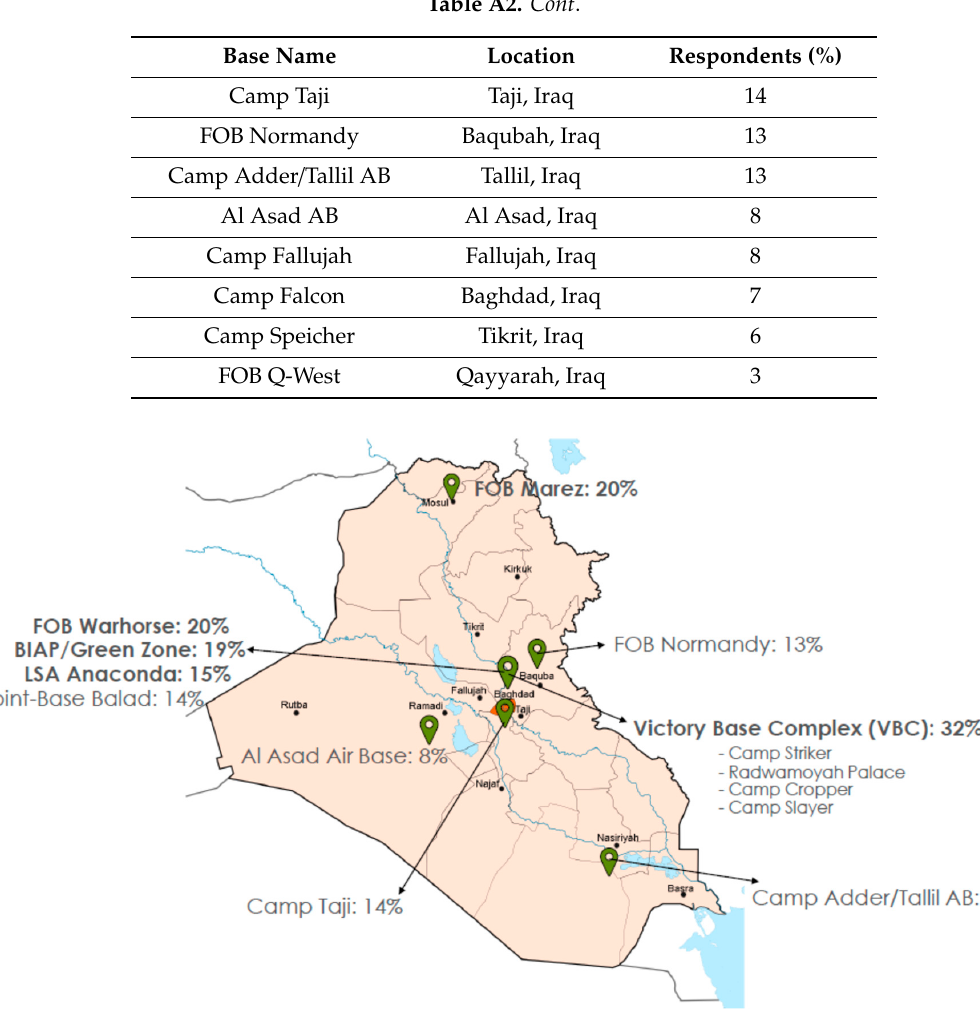
Figure B1. All Deployment Location(s). Figure A1. All Deployment Location(s). FOB: Forward Operating Base, BIAP: Baghdad Intl.